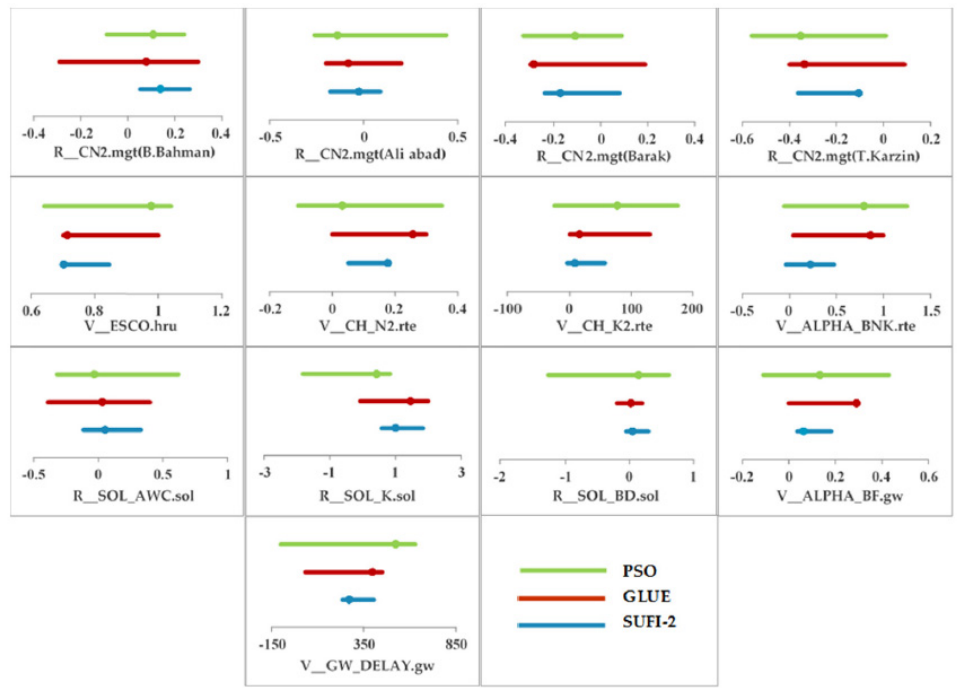
Figure 6. Uncertainty ranges of the parameters based on all three methods applied in Salman Dam Basin, Iran. The points in each line show the best value of the parameters, r_ refers to a relative change where the current values are multiplied by one plus a factor from the given parameter range, and v_ refers to the substitution by a value from the given parameter range. (Source: Hooshmand et al. [13]).